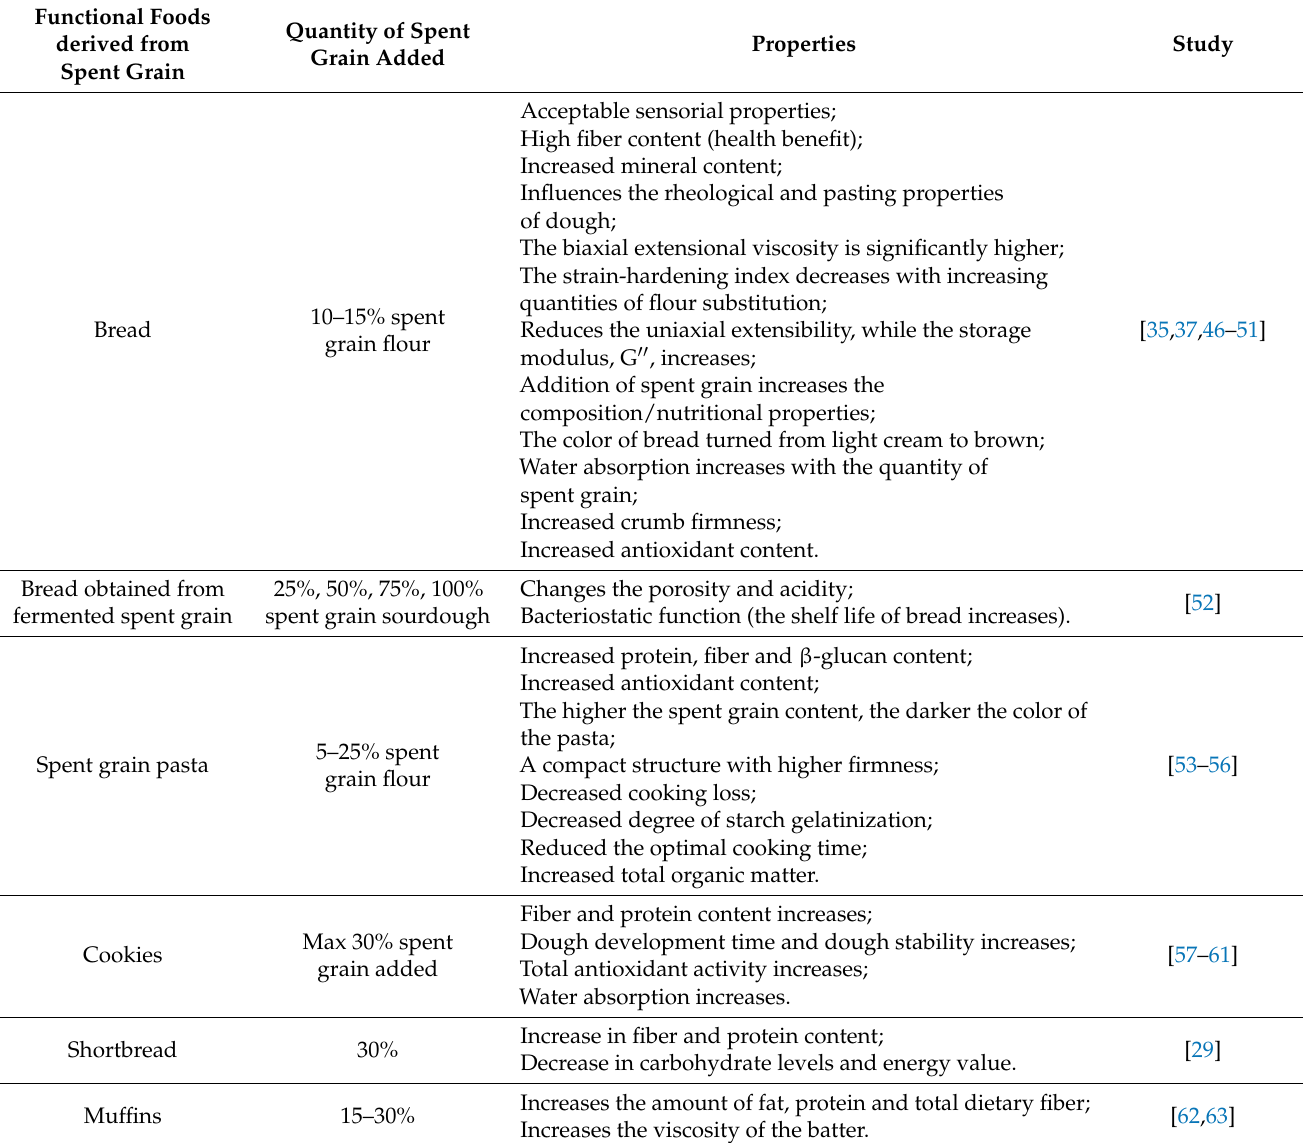
Table 2. Characteristics of functional foods derived from spent